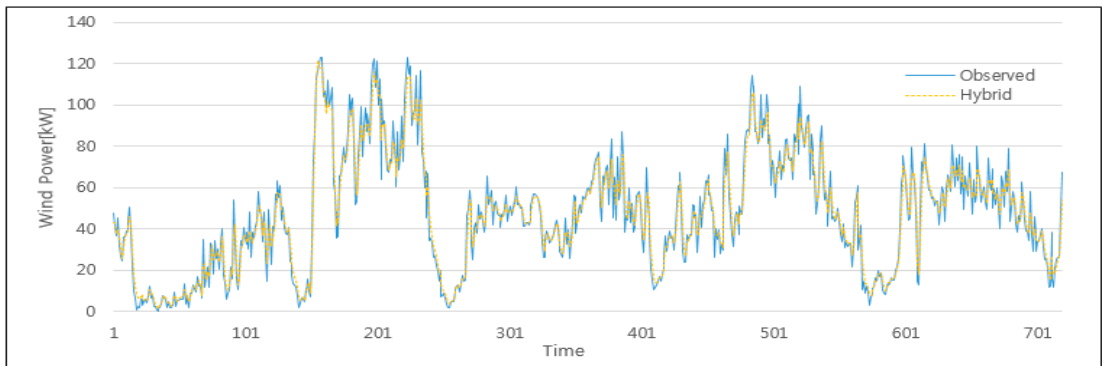
Figure 11. Comparisons between the observation and hybrid model in A region of Jeju Island.